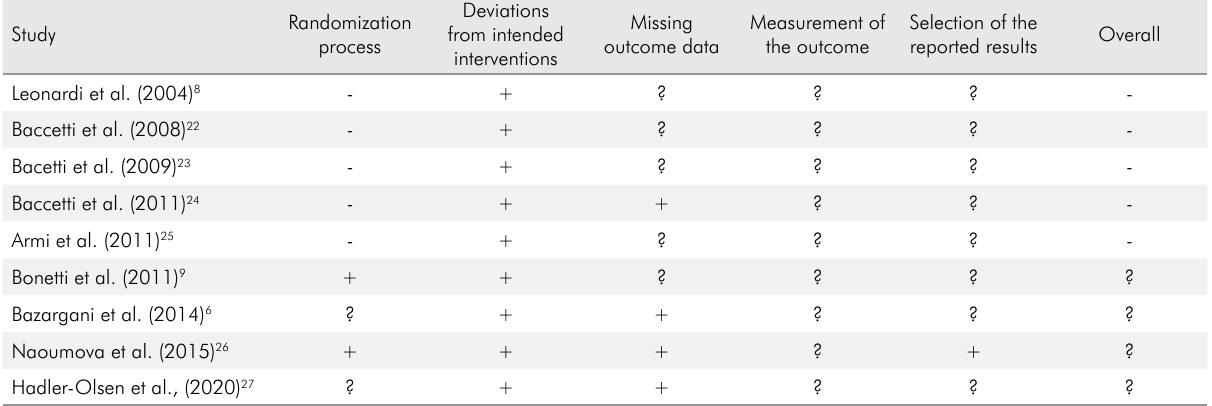
Table 4. Summary of the risk of bias assessment of the included studies.